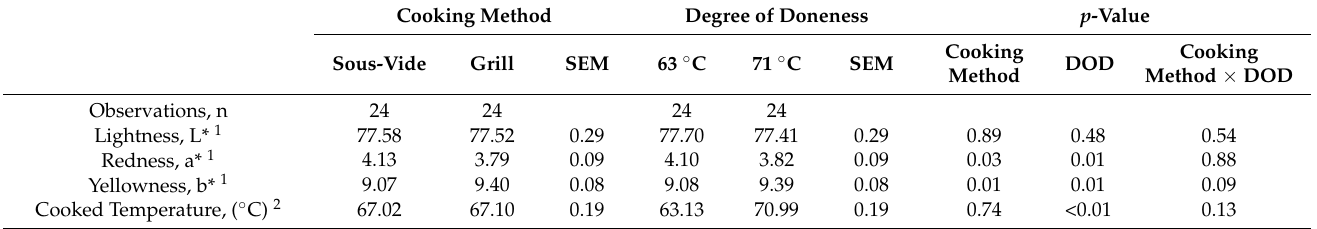
Table 3. Effects of cooking method and degree of doneness (DOD) on instrumental color of cooked pork